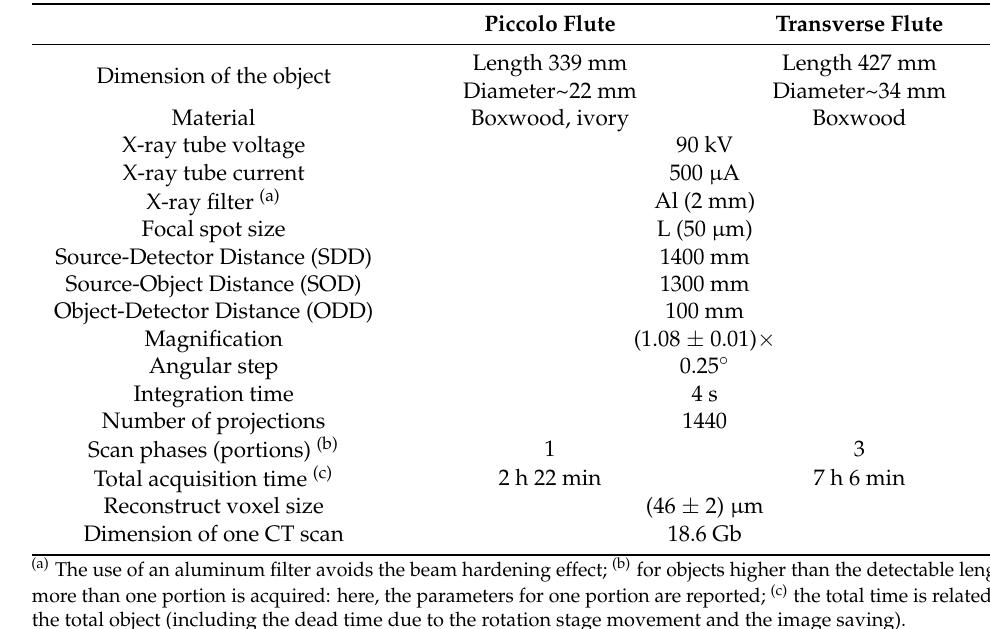
Table 2. Experimental CT conditions.